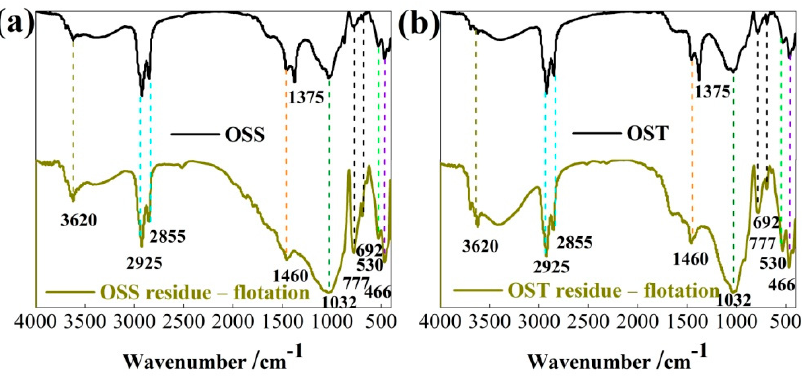
Figure 8. ( a ) FTIR spectra of the OSS and OSS residue from flotation treatment; ( b ) FTIR spectra of the OST and OST residue from flotation treatment; Flotation conditions: T t = 25 min, without chemical additive, T p = room temperature (24 °C), R s = 1340 r/min, L/OS = 12:1.